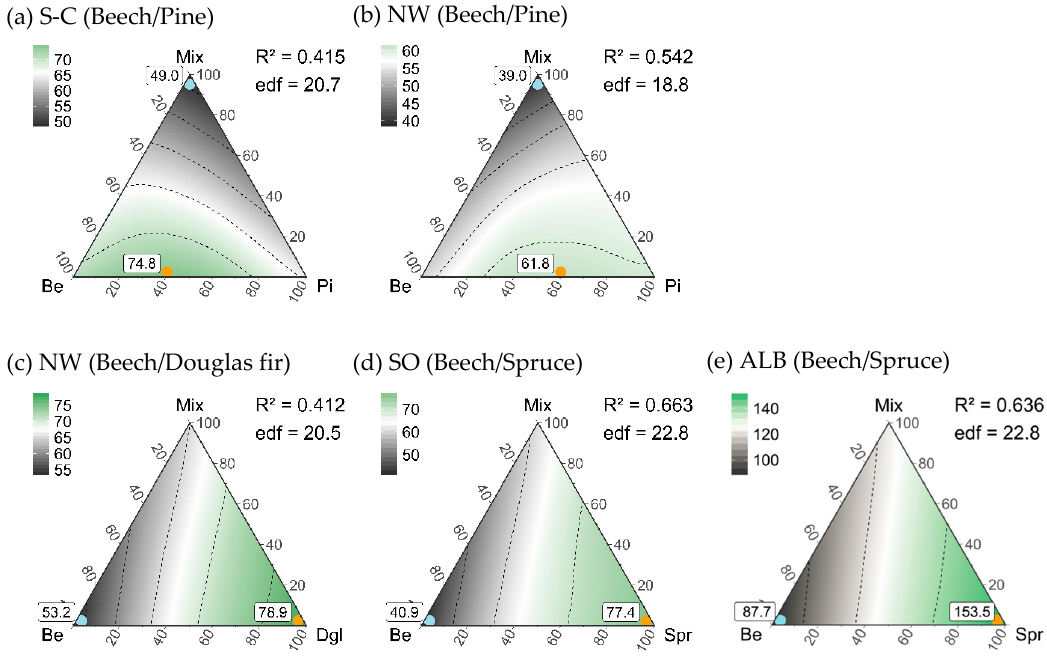
Figure 3. Gamma diversity (species richness) of vascular plants along compositional gradients of pure beech (Be), pure conifer (Pi = Pine, Dgl = Douglas fir, Spr = Spruce) and mixed stands (Mix) for ( a ) Schorfheide-Chorin (S-C), ( b , c ) Northwestern Germany (NW), ( d ) Solling (SO), ( e ) Schwäbische Alb (ALB). The stand type composition was varied in steps of 10% using 1000 resamplings of 17 plots per step (66 unique stand type compositions). The diversity response to stand type composition is characterized by R 2 and estimated degrees of freedom (edf). Labelled dots mark the maximum (orange) and minimum (light blue) gamma diversity.